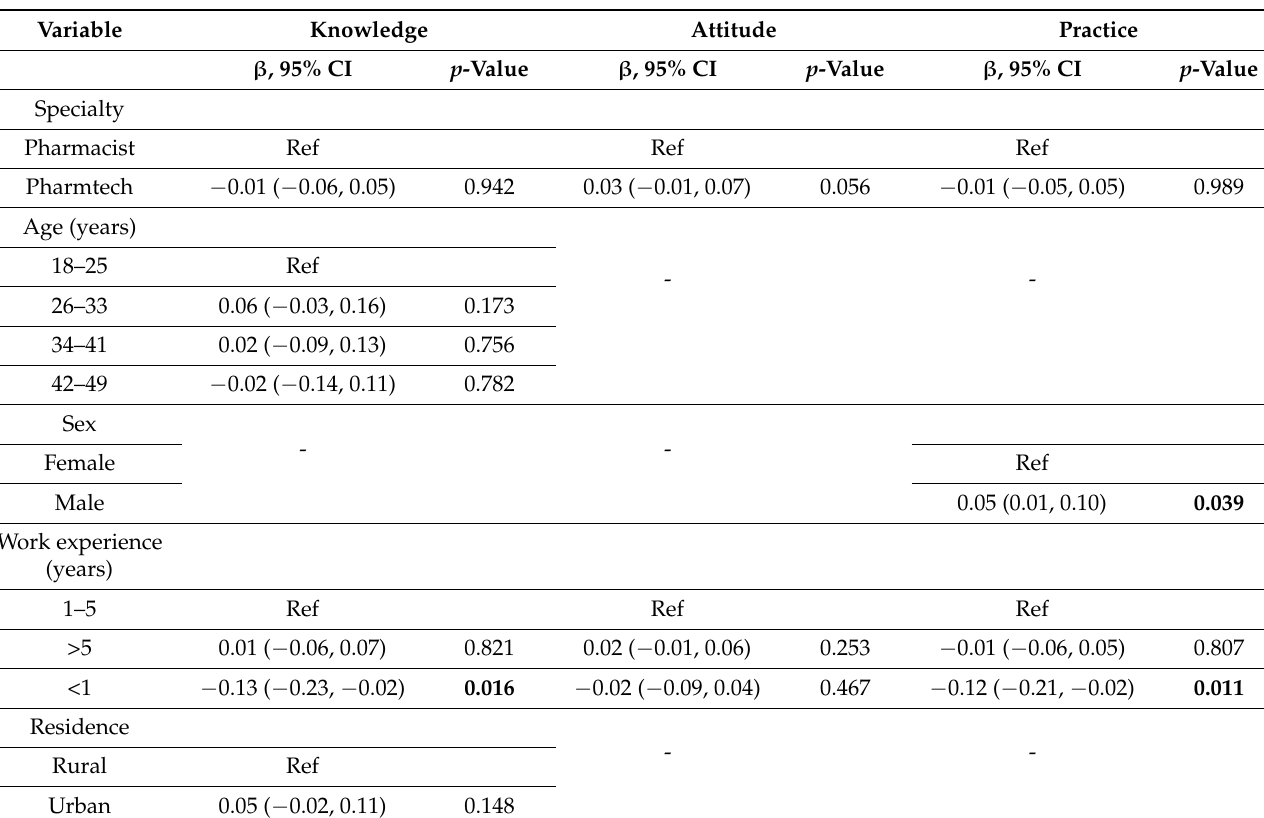
Table 4. Linear regression of factors associated with mean knowledge, attitude, and practice scores of ABU and AMR.